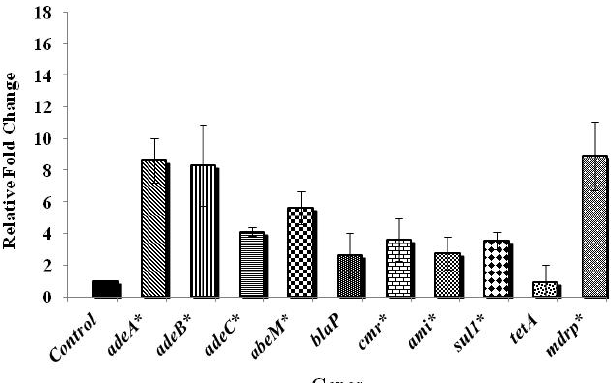
Figure 1. Effect of chlorine exposure on antibiotic resistance gene expression in A. baumannii ATCC 17978.